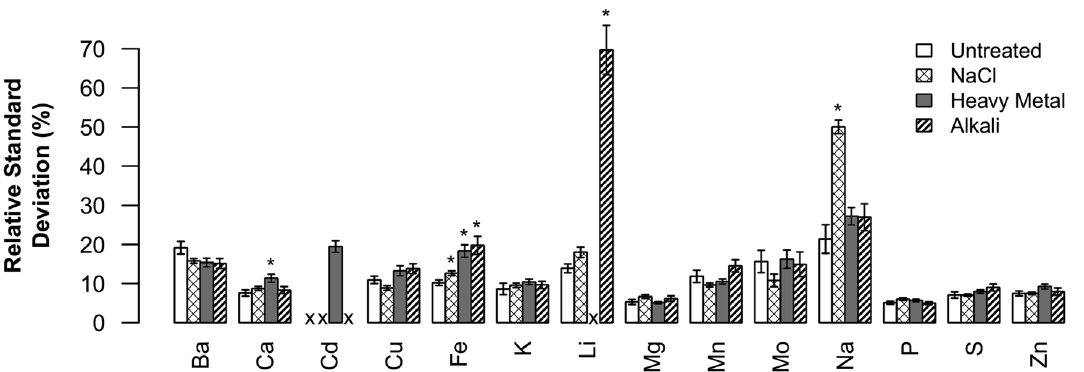
Figure 2. Similar variability was found for 9 of the 14 elements under all soil conditions. Columns represent the average variability ( 6 SE) of an element in Col-0 control seeds under a specific soil condition, expressed in terms of the standard deviation relative to the mean (%RSD, percent relative standard deviation). In total, 139 flats were processed for NaCl soil, 92 for heavy metal soil, 35 for alkali soil and 37 for untreated soil. However, some elements were not detected in every flat. The exact n-value for each circumstance can be found in Figure 1. Circumstances for which no data was collected are represented by an ‘‘X’’. * Elements for which a statistically significant difference between standard and modified soil conditions was observed (t-test, p , 0.05, Bonferroni multiple test